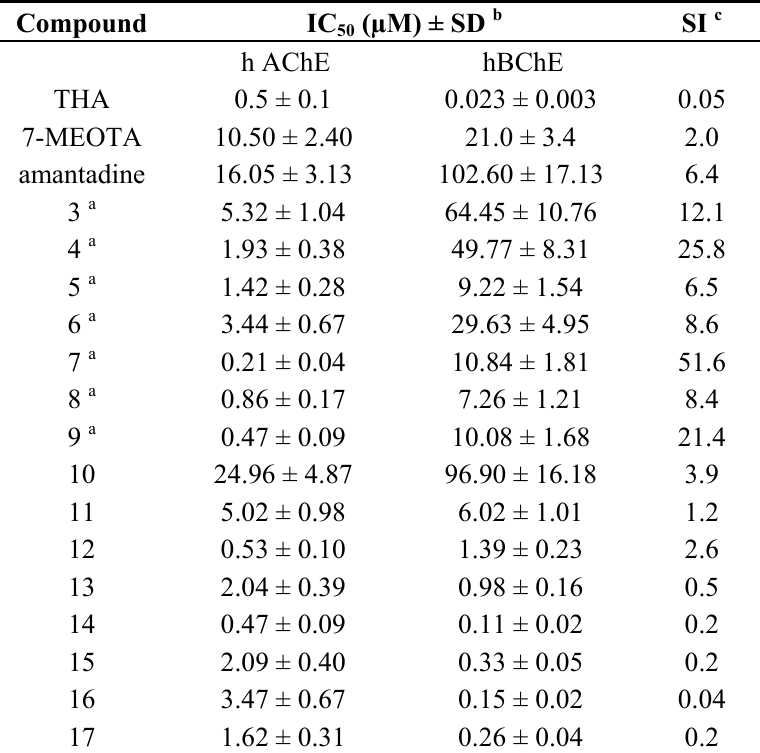
values of amines, standards and tested Table 1. IC 50